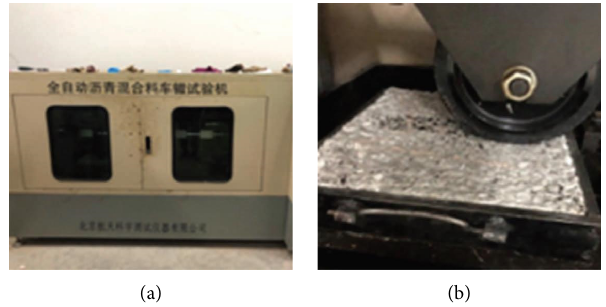
Figure 5: High-temperature stability test. (a) Rutting tester. (b) Rolling